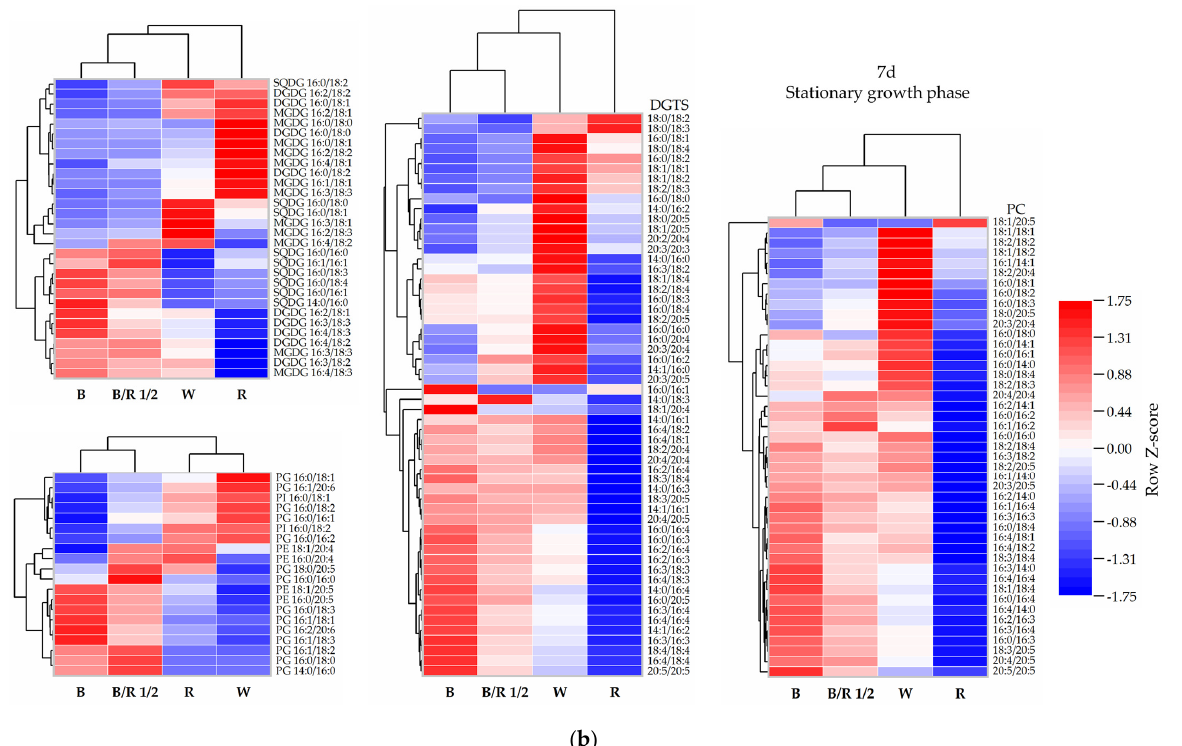
Figure 6. Heat map of relative contents of single lipid species in H. pluvialis green cells cultivated under different light spectra. ( a ) Exponential growth phase; ( b ) stationary growth phase. Row Z-Score scaling method was used for visualization in heat maps and allows for comparison of the content of the same single lipid species between different light spectra groups. Red color indicates comparatively high content, whereas blue color suggests comparatively low content. In ( a , b ), B—blue light; B/R 1/2—blue/red light 1/2; R—red light; W—white